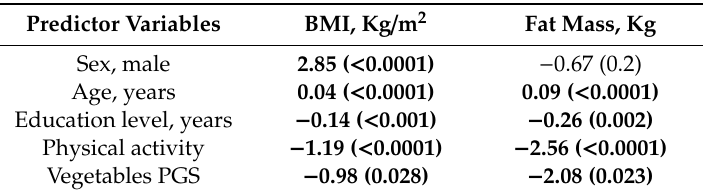
Table 2. Results of polygenic risk score